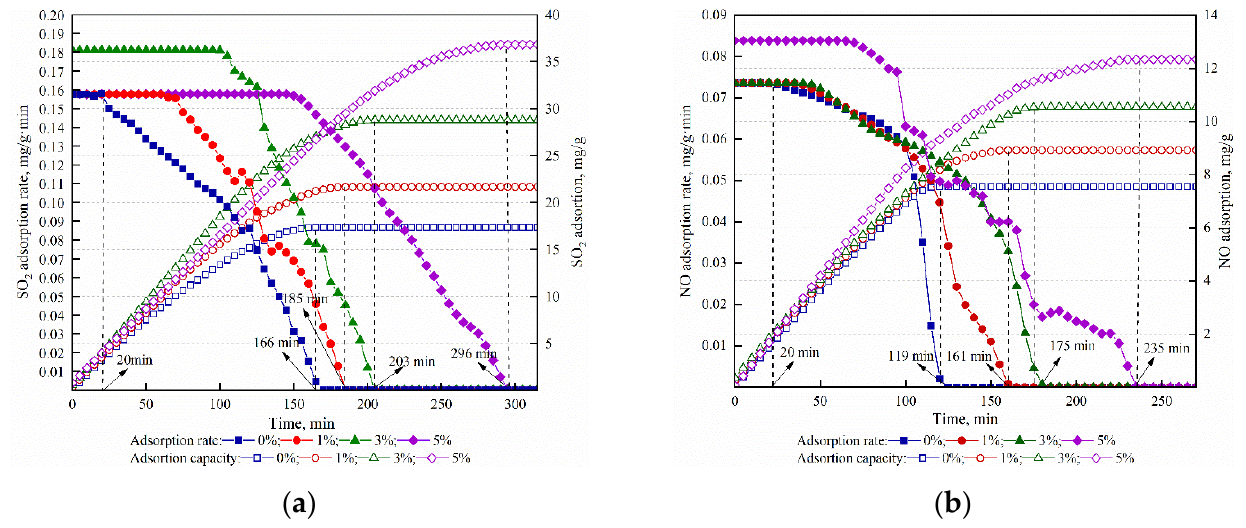
Figure 9. ( a ) The effect of H 2 O concentration on SO 2 adsorption performance; ( b ) the effect of H 2 O concentration on NO adsorption performance.